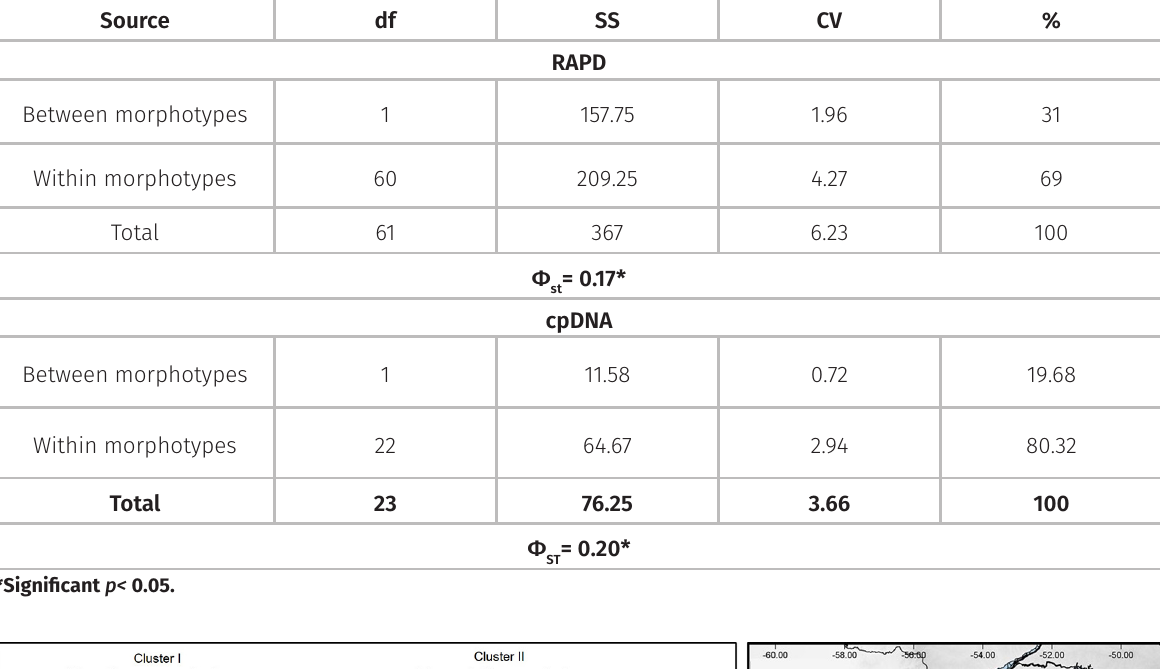
Table IV. Hierarchical distribution analysis of genetic variation estimated by AMOVA between and within morphotypes of Turnera sidoides subsp. carnea with RAPD markers and cpDNA sequences. df= Degrees of freedom, SS= sum of squares, VC= variation coefficient, %= percentage of the total variance.